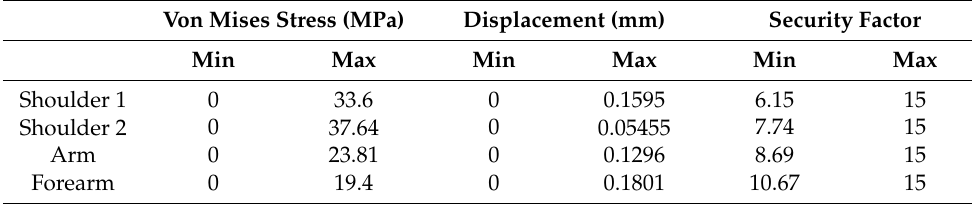
Figure 4. Finite element analysis on Autodesk Inventor of 3D printed arm pieces. Table 2. Values of Finite element analysis on Autodesk Inventor of 3D printed arm